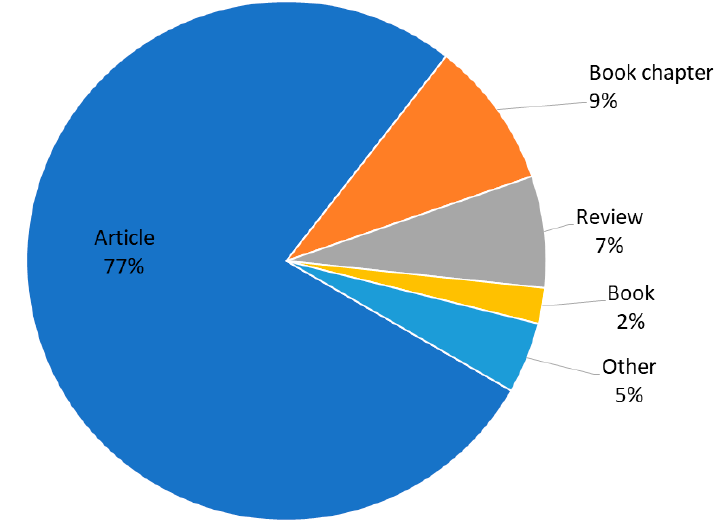
Figure 3. Type of scientific production on unaccompanied minors in the last 30 years (1987–2017).